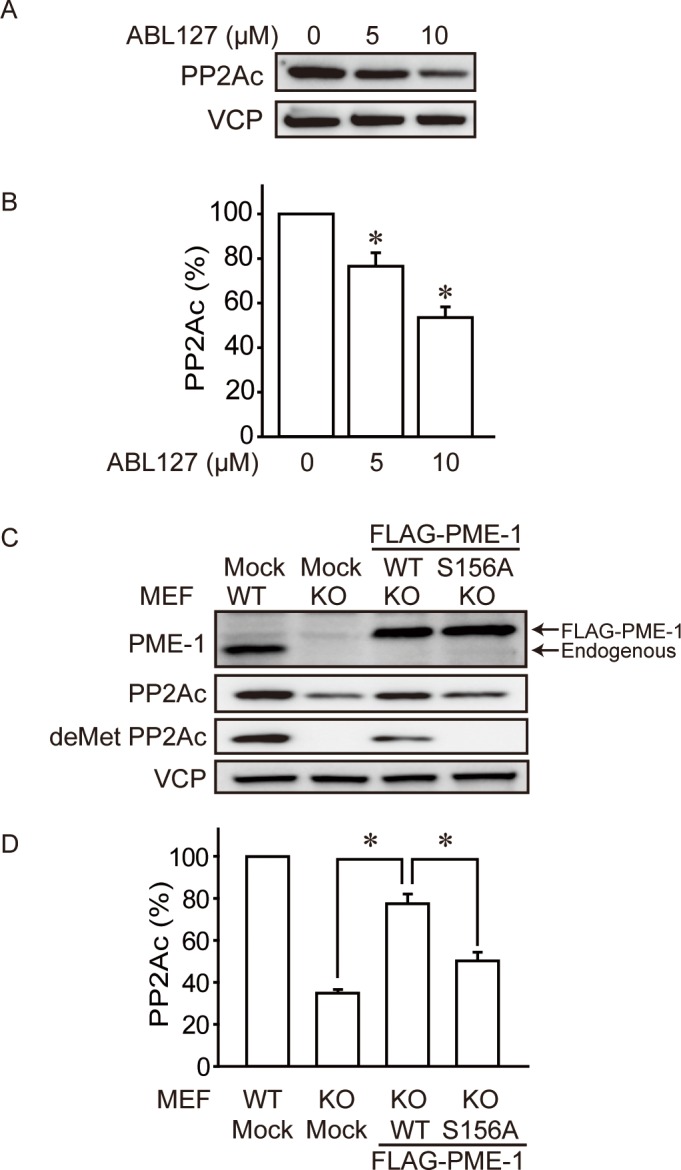
Methyl-esterase activity of PME-1 is required to maintain levels of PP2Ac.(A) PME-1 inhibitor decreases PP2Ac protein levels. WT MEFs were treated with ABL127 (5 or 10 μM) for 48 hr and levels of proteins were determined by immunoblotting. Representative images (A) and quantitative data (B) from 4 independent experiments are shown. *: P<0.05 vs. ABL127 untreated. (C-D) Methyl esterase activity of PME-1 is required to maintain PP2Ac levels. PME-1 KO MEFs were expressed FLAG-PME-1 WT or S156A (methyl esterase dead), and levels of proteins were determined by immunoblotting. Empty vector was used as mock. Representative images (C) and quantitative data (D) from 3 independent experiments are shown. *: P<0.05 vs. FLAG-PME-1 WT expressed KO MEFs.